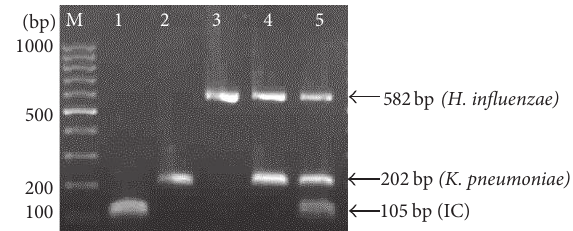
Figure 1: Representative agarose gel electrophoresis of the multiplex PCR using reference strains of H. influenzae and K. pneumoniae